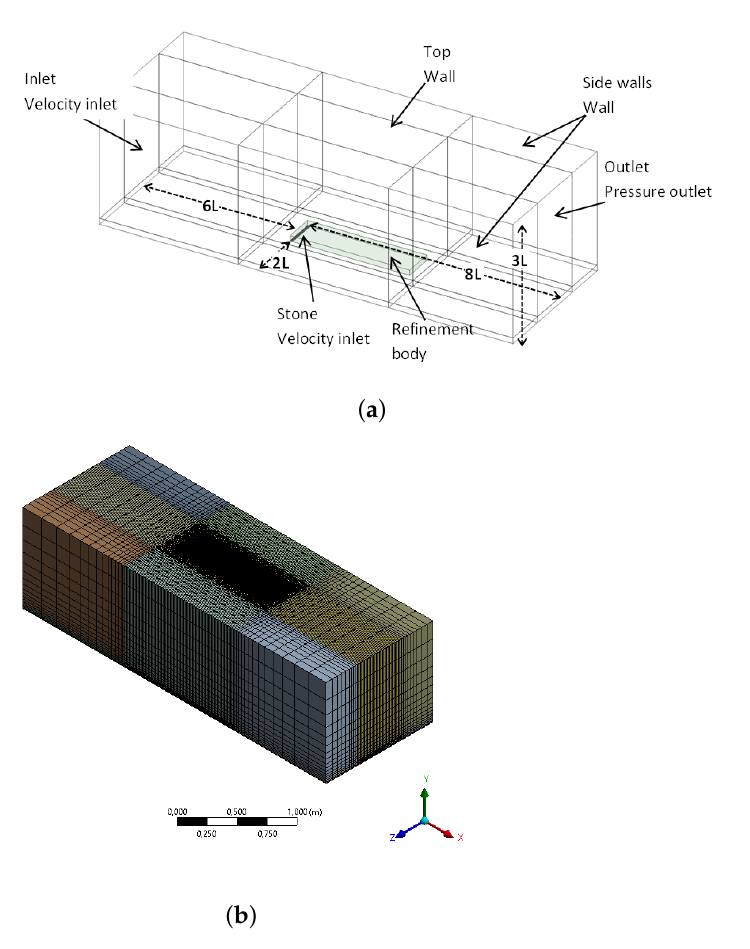
Figure 3. ( a ) Domain dimensions and boundary conditions with L (=255 mm) as the length of the porous stone; ( b ) view of the